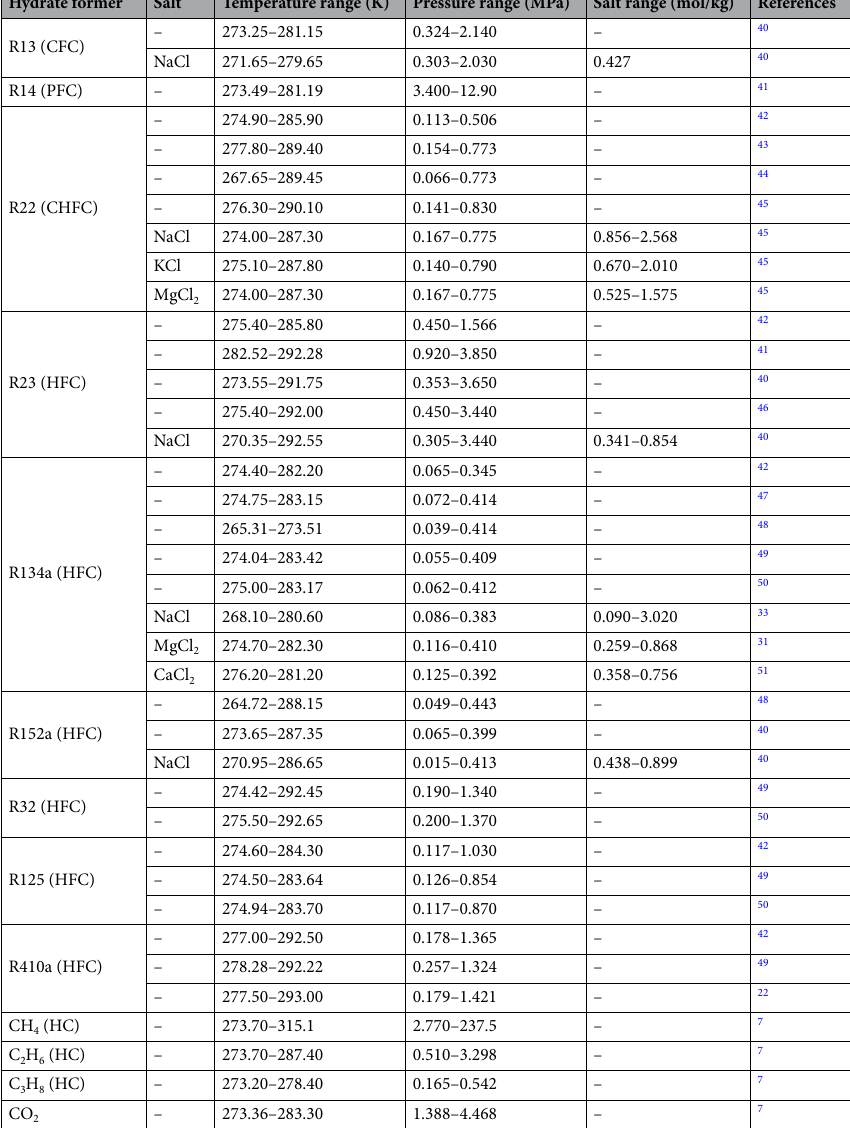
Table 2. Ranges of phase equilibrium data for refrigerant hydrates in different aqueous